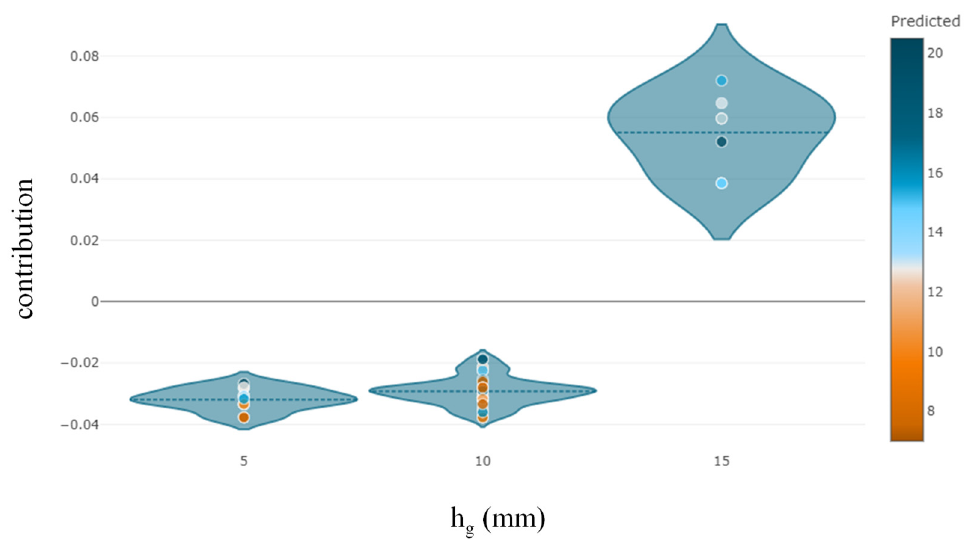
Figure 10. Feature contribution of h g towards the target variable.